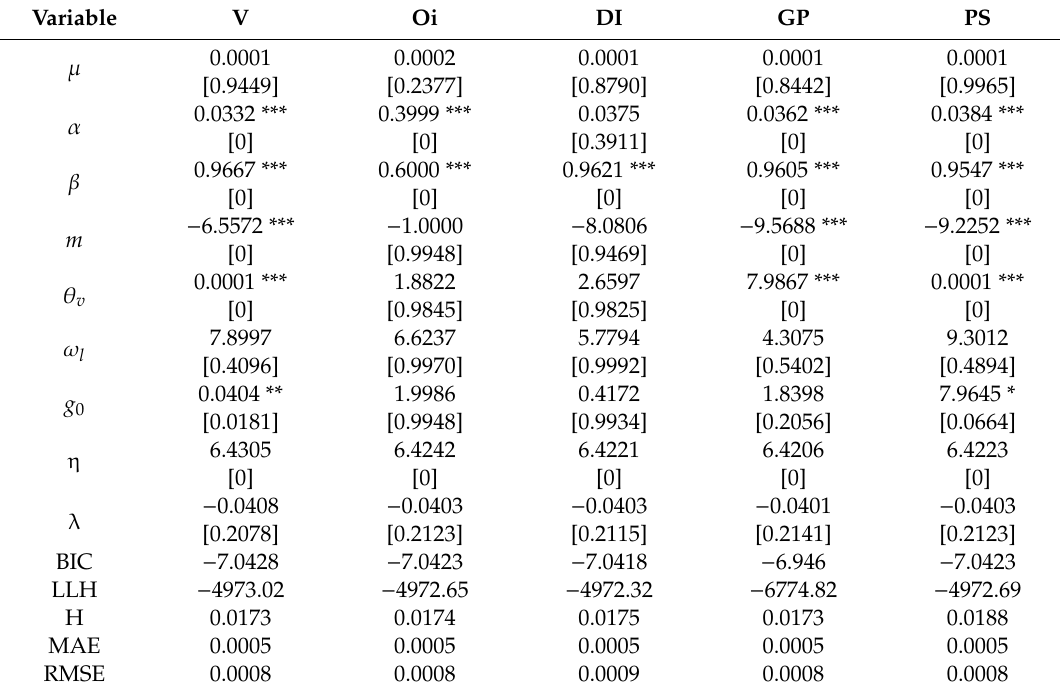
Table 6. Estimation results of high-frequency and single-factor fluctuation e ff ect